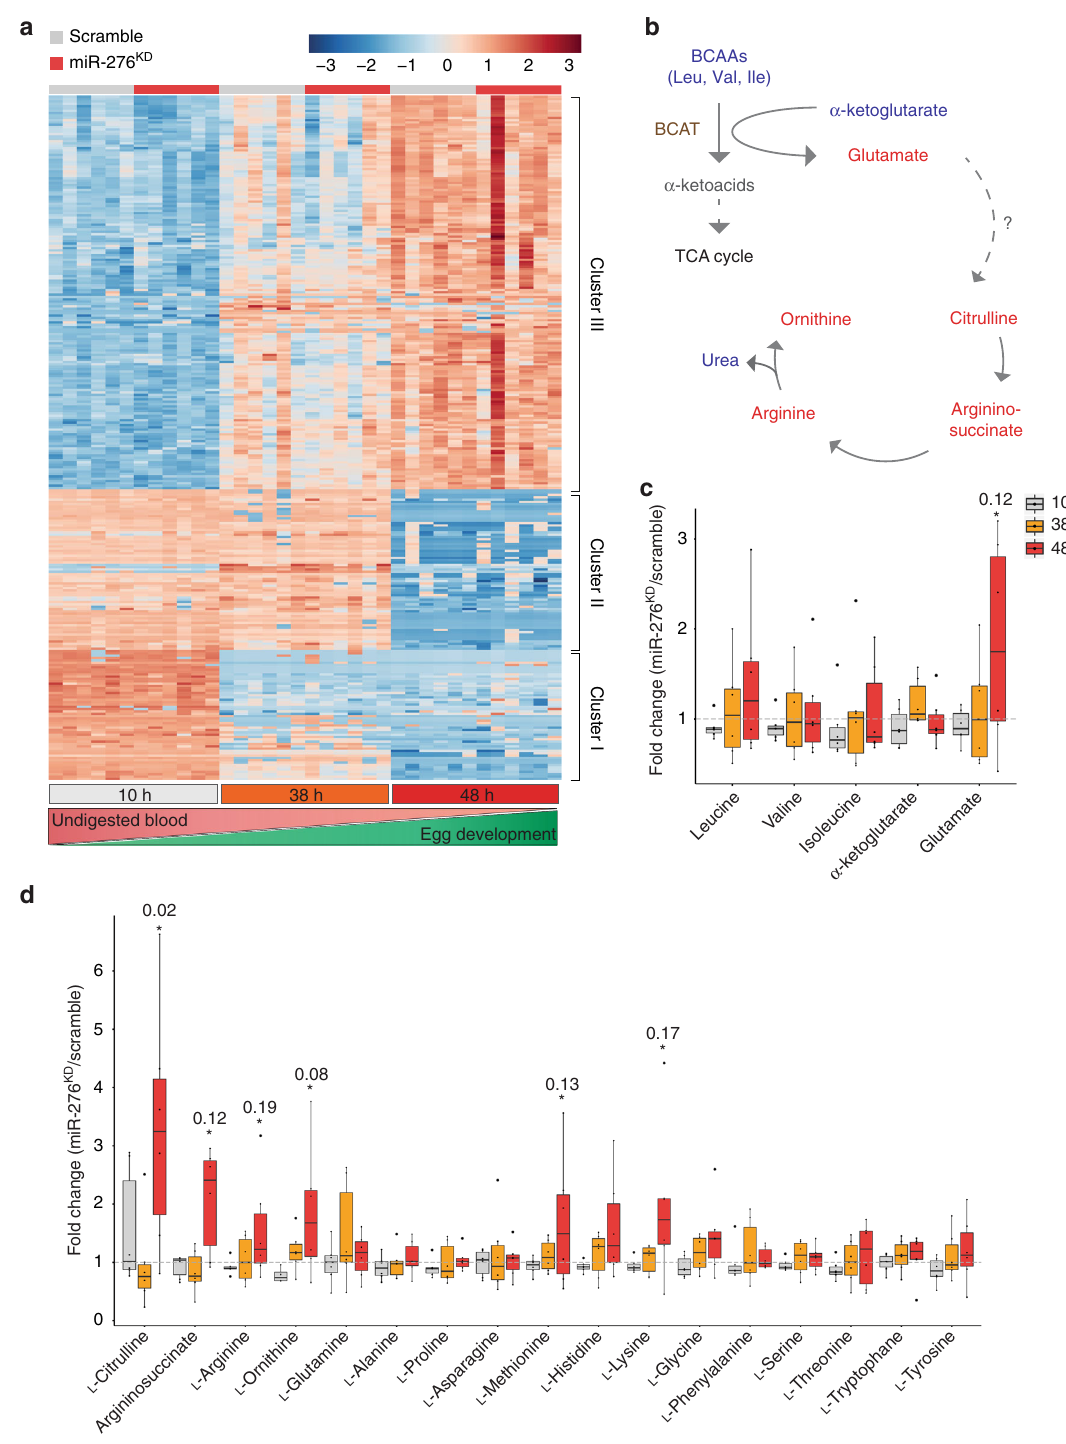
tuning BCAT transcript levels and that miR-276 silencing prolongs the catabolic phase of the mosquito reproductive cycle. miR-276 regulates oogenesis and P. falciparum sporogony